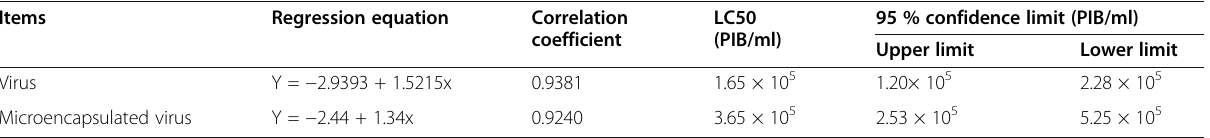
Table 4 Regression equation, correlation coefficient, and LC 50 between the viral tested concentrations and the mortality of 3rd instar larvae